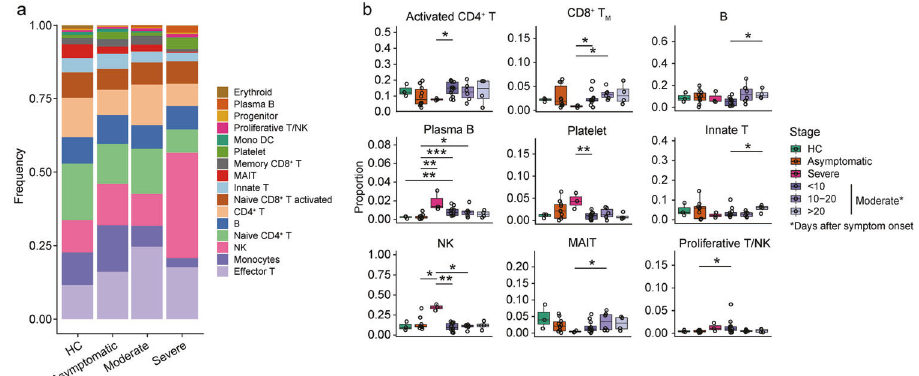
Fig. 2 Differences in major cell types compositions across disease conditions. a Proportion of cell types in PBMCs of healthy controls (HCs, n = 3), moderate ( n = 8), severe ( n = 1), and asymptomatic patients ( n = 7). Colored according to cell type information. b Boxplots showing the percentages of each cell type to total cell number per PBMC sample in four disease conditions (HCs, asymptomatic, moderate, and severe) and stages. Boxes are colored according to disease conditions and stages of the moderate condition. The PBMC samples from moderate patients were classi fi ed into 3 stages (<10 days, 10 – 20 days, and >20 days) based on the days after symptom onset. Boxplots indicate the median and interquartile range (IQR); the whiskers represent 1.5 times the IQR. Each circle represents the proportion of each PBMC sample. Two-sided Kruskal – Wallis test was used for analysis, and a p value < 0.05 is considered signi fi cant. * p < 0.05, ** p < 0.01, *** p < 0.001. No asterisk indicates no statistical signi fi